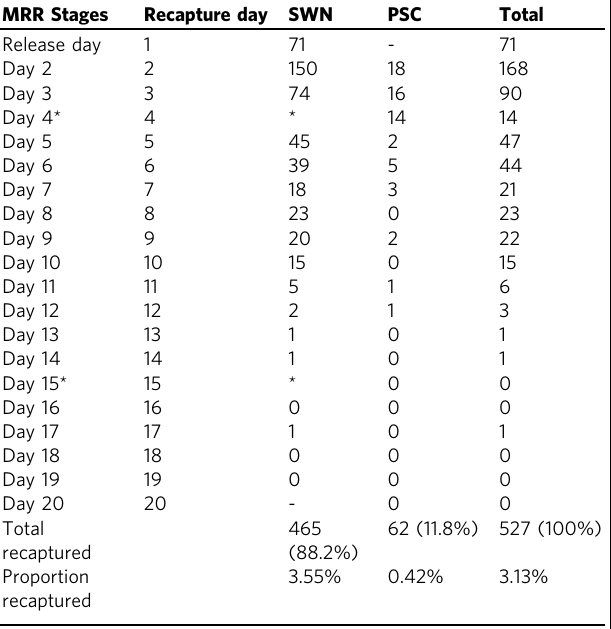
Table 1 Numbers of marked males collected using swarm collection (SWN) and pesticide spray catches (PSC) during the 20 days of recapture of the MRR (Mark-Release- Recapture) study.